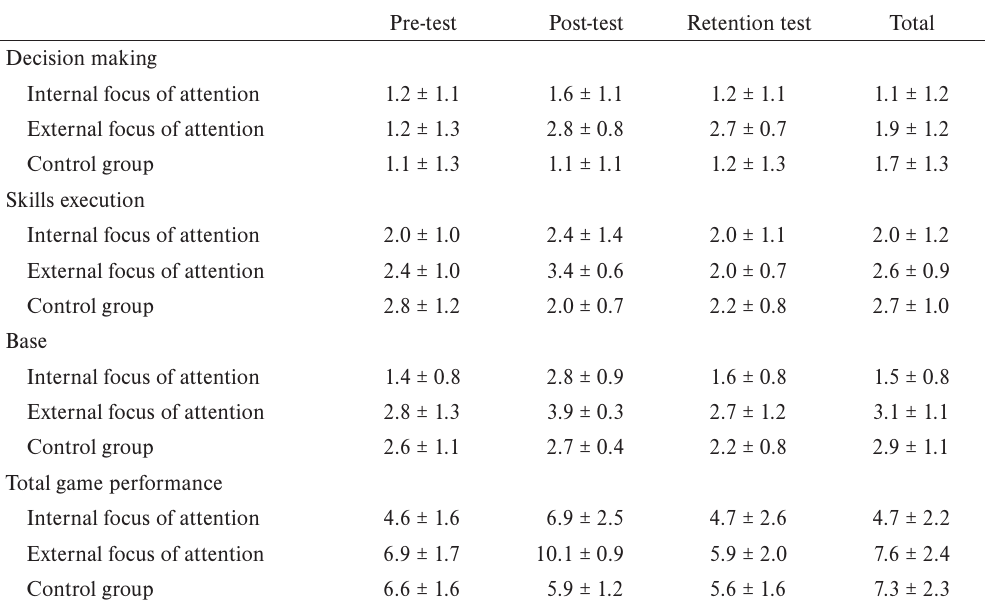
Performance scores (presented as M ± SD) for each group in pre-, post- and retention